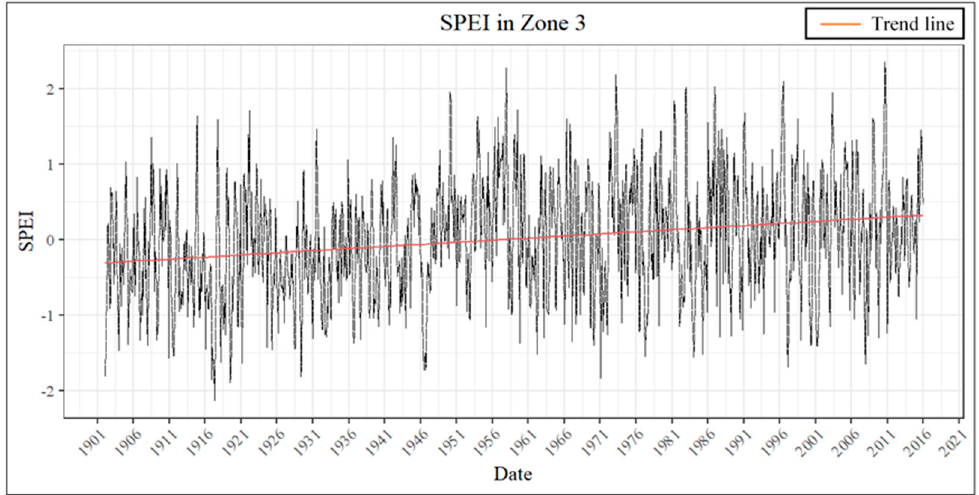
Figure 12. Three-month SPEI from 1902–2015 for zone 3.